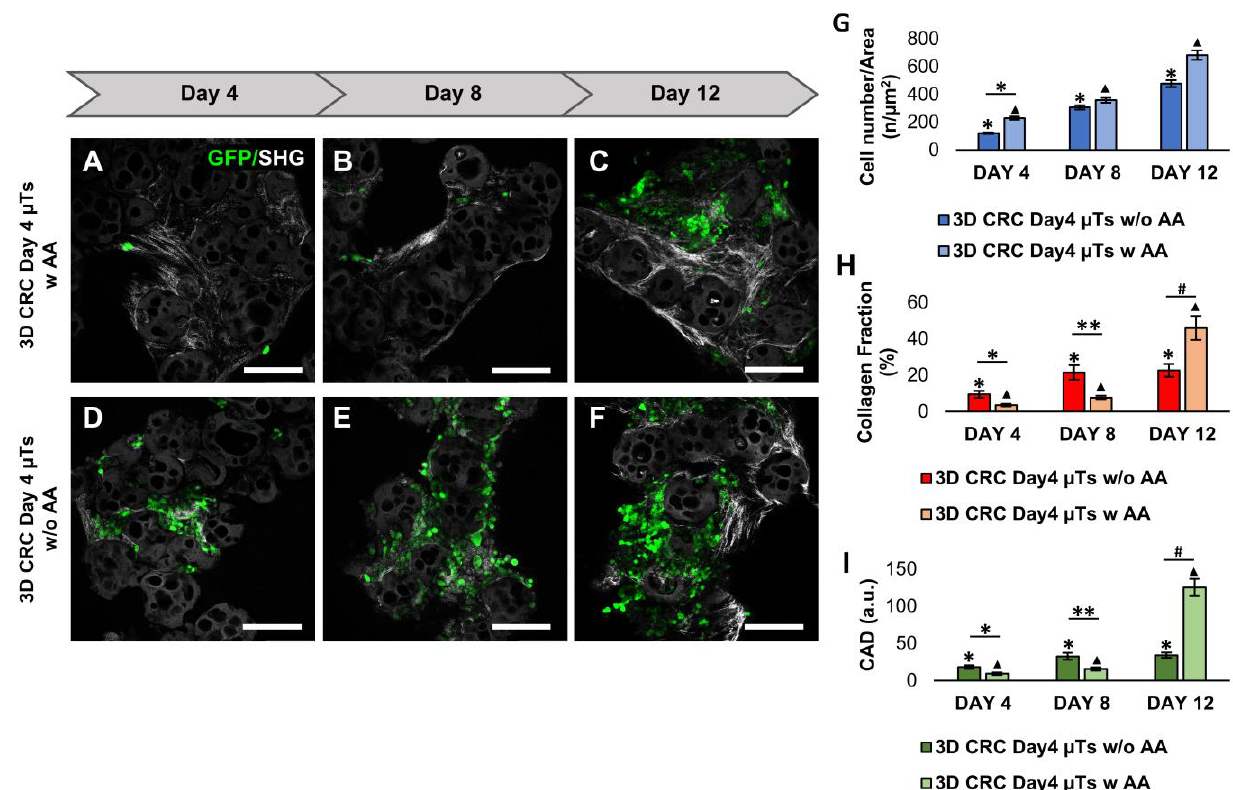
Figure 3. Comparison of cancer cell counts and extracellular matrix (ECM) remodeling between the 3D CRC Day4 µ Ts with Ascorbic Acid (AA) and 3D CRC Day4 µ Ts without AA monitored on days 4, 8, and 12 of culturing. ( A – C ) Confocal images of 3D CRC Day4 µ Ts w AA; ( D – F ) confocal images of 3D CRC Day4 µ Ts w/o AA; scale bar: 150 µ m: green fluorescent protein (GFP) expressed by HCT-116 cells (green) and collagen Second Harmonic Generation (SHG) signal (gray). ( G ) Graph of cell numbers over time for the HCT-116 cells in the microtissues; ( H ) collagen fraction analysis; ( I ) collagen assembly degree (CAD) analysis. All the experiments were performed in triplicate (n = 3), and the values represent the mean and the mean standard error ( ∗ ; ∗∗ ; ; # p < 0.05).